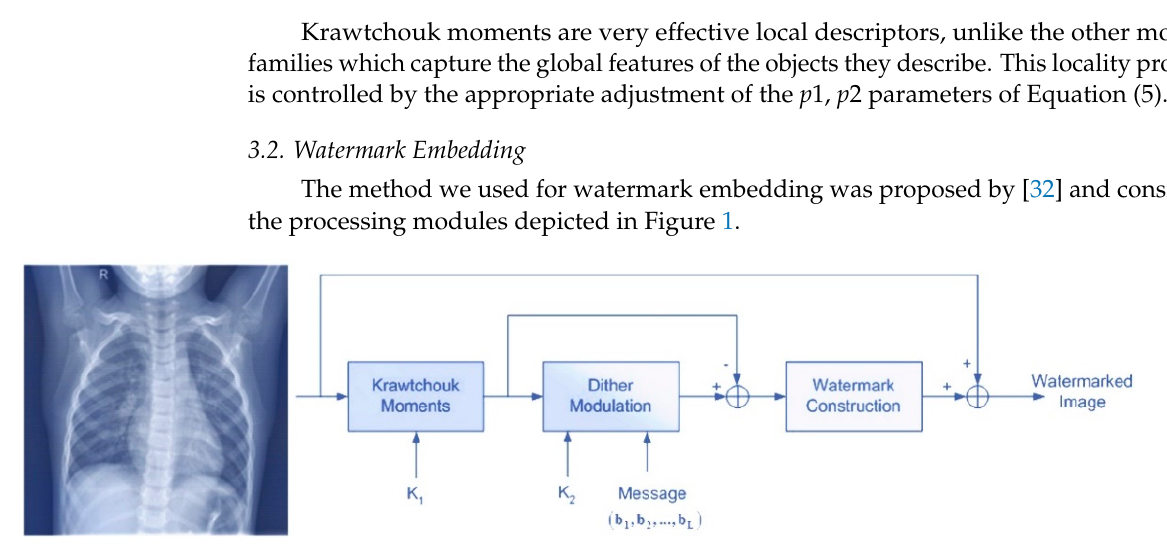
Figure 1. Watermark embedding